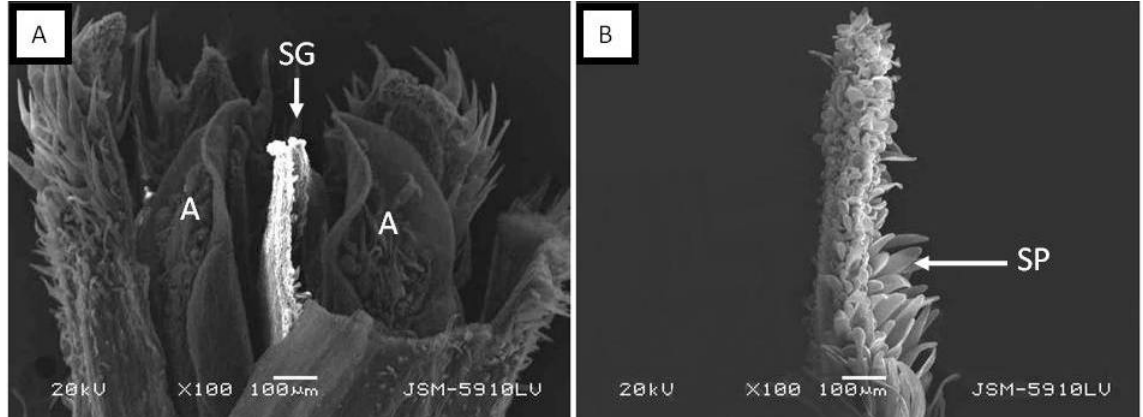
Fig. 4. SEM analysis of stigma in young (A) and mature (B) hermaphrodite florets in H. annuus . A. Stigma that is not divided in two parts in young floret; B. Stigmatic papillae in mature floret. A: Anther; SG: Stigma; SP: Stigmatic